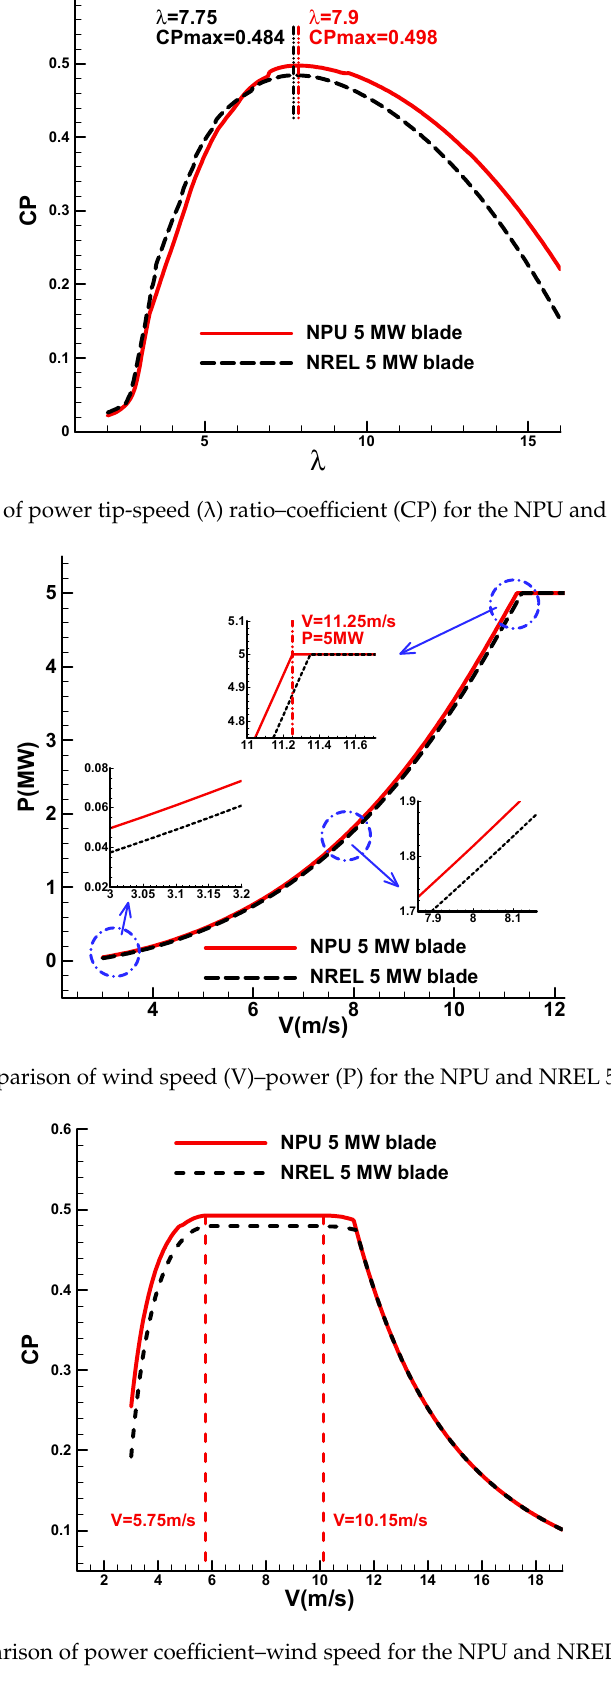
Figure 23. Comparison of power coefficient–wind speed for the NPU and NREL 5 MW blades.